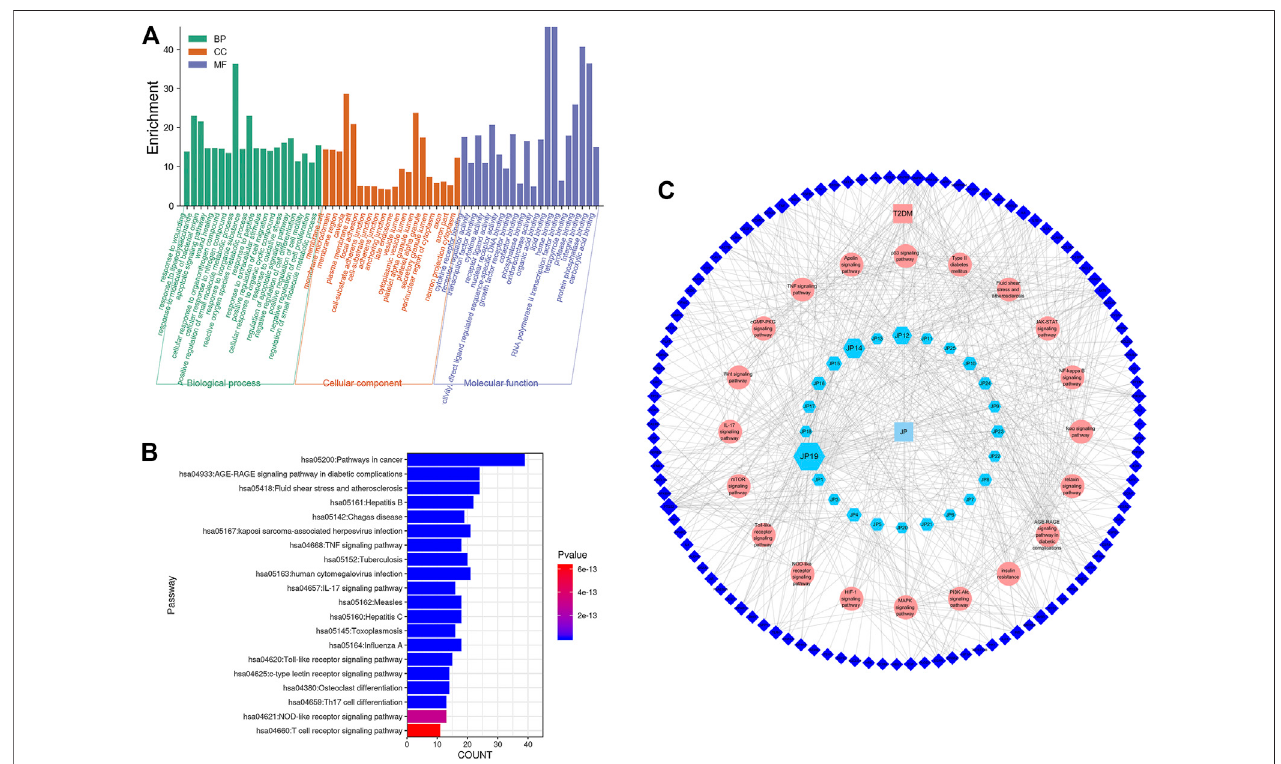
FIGURE 5 | Main pathways of GP for T2DM. (A) GO enrichmentanalysis oftargets ofGP ( Gynura procumbens ) decoction, (B) Analysis of KEGG enrichment in 20 pathways as targets of GP ( Gynura procumbens ) decoction, and (C) component-pathway-gene network of GP for T2DM.